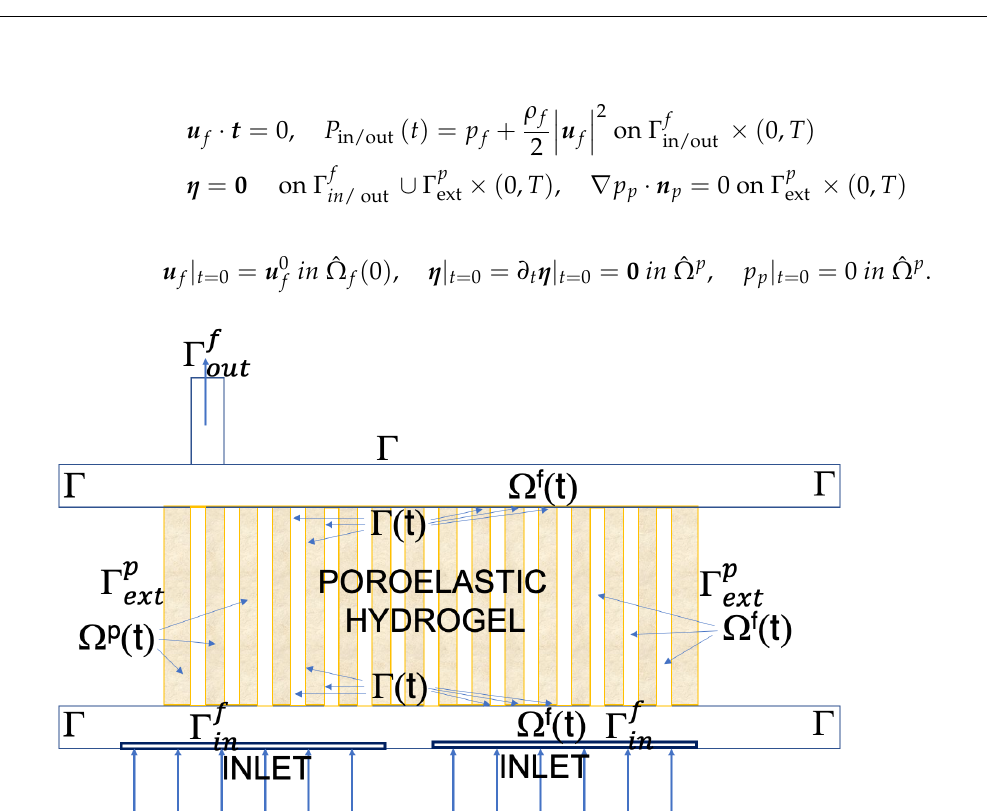
Figure 7. A sketch of a 2D slice of the fluid and poroelastic structure domains together with their